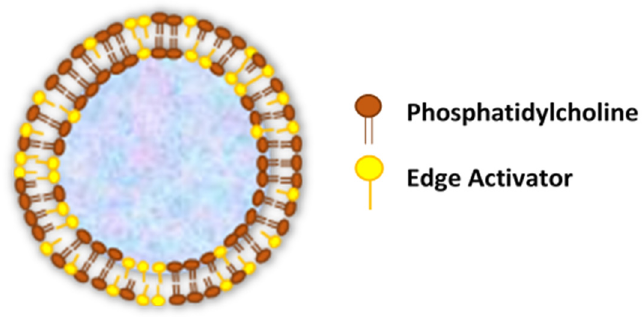
Figure 1. Structure of transfersomes.